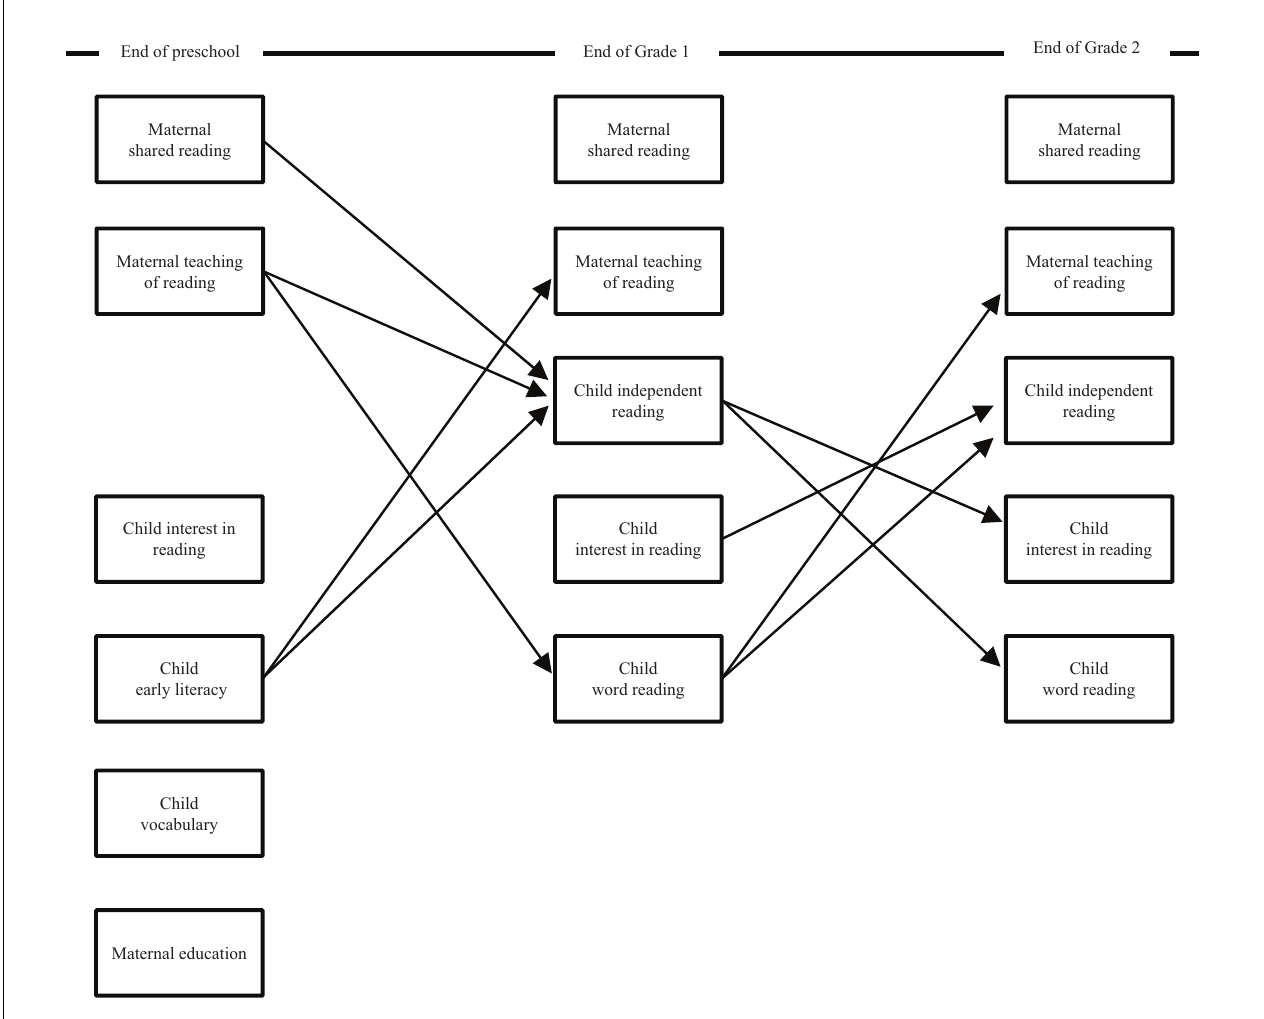
FIGURE 1 | Hypothesized model relating maternal home literacy activities and child word reading, independent reading, and interest after controlling for child vocabulary and maternal education ( N = 378). Arrows depicting correlations and auto-regressors were omitted for